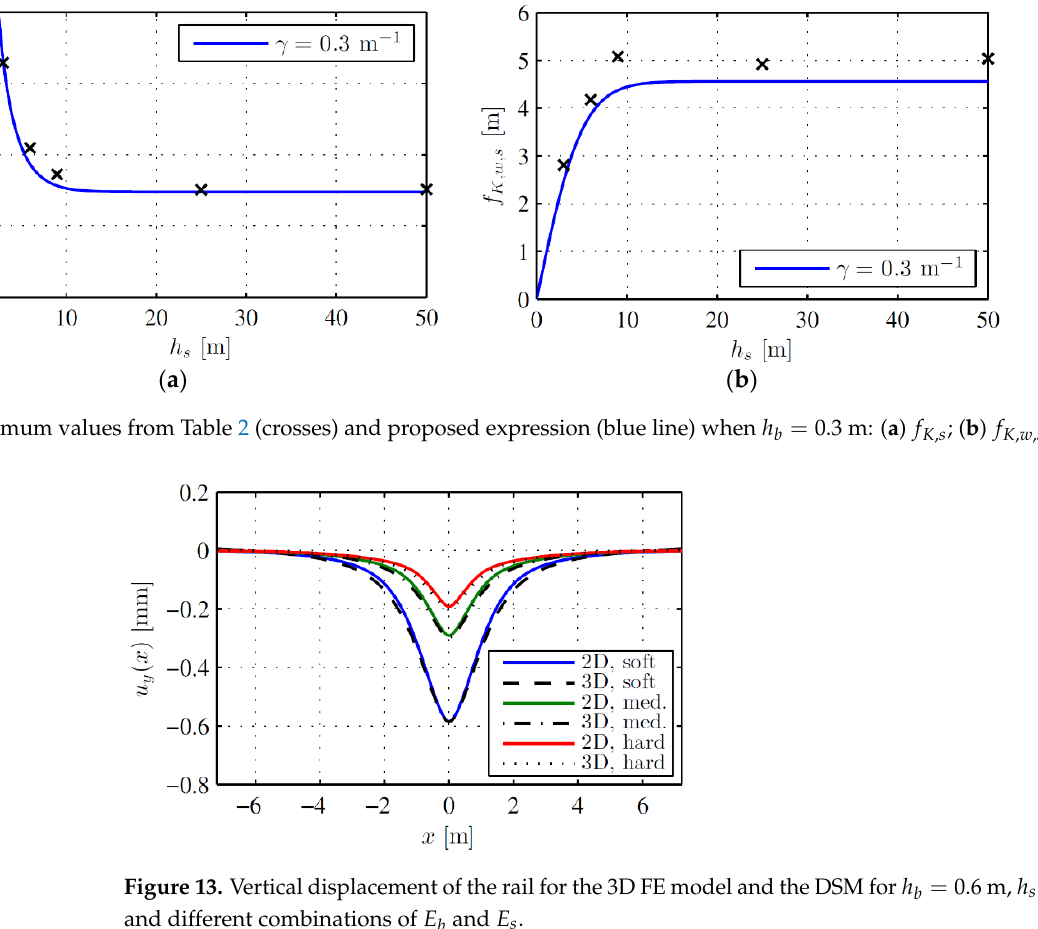
Table 6. Values of the mass and respective error, optimum values from Table 3.